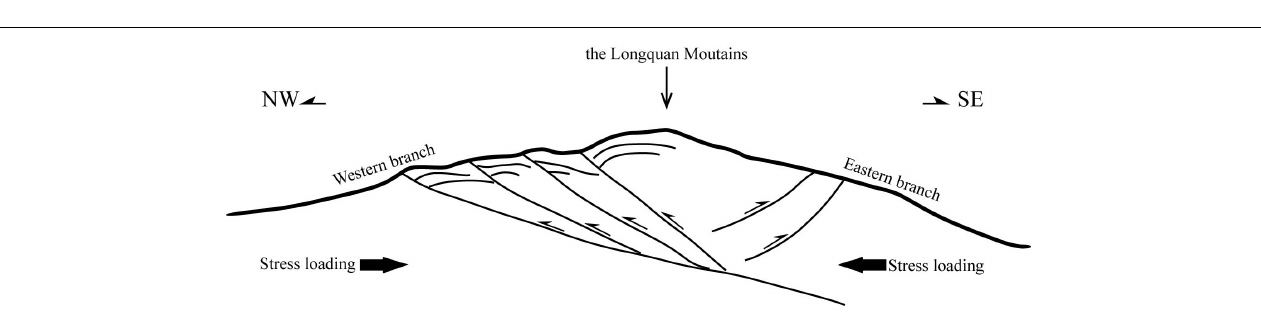
FIGURE 1 | Geological setting and epicentral map of M L ≥ 2.0 earthquakes since 2009 near the epicenter of the 3 February 2020 M S 5.1 Qingbaijiang earthquake. Inset map in the upper right corner highlights the study area (red rectangle) in the main figure relative to the major crustal blocks in China. Purple lines indicate active faults: LMSF, Longmenshan fault zone; LQSF, Longquanshan fault zone; LQSF-EB, Eastern Branch of the Longquanshan fault zone; LQSF-WB, Western Branch of the Longquanshan fault zone; PXF, Pujiang-Xinjin fault.